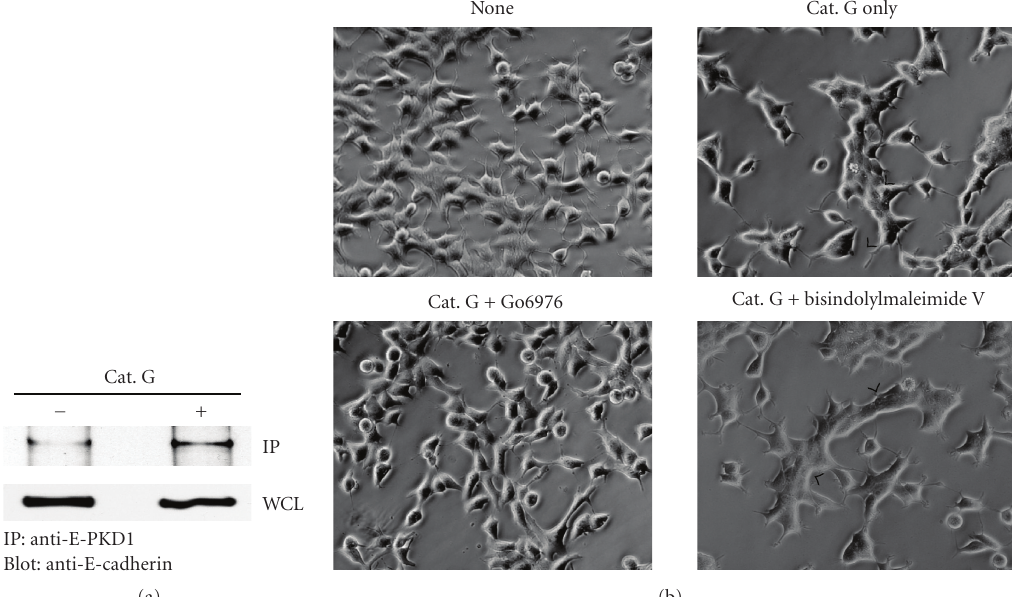
Figure 6: Cathepsin G promotes E-cadherin/PKD1 complex formation in MCF-7 cells. MCF-7 cells treated with cathepsin G for 10 hours were analyzed by immunoprecipitation and western blot analysis as described in Materials and Methods. (a) Immunocomplexes with anti- PKD1 antibody or whole-cell lysates (WCLs) were analyzed by immunoblotting using an anti-E-cadherin antibody. (b) After washing, the adherent cells were treated with cathepsin G in the absence or presence of 5 μ M Go6976 or 5 μ M of the negative control compound bisindolylmaleimide V for 5 hours. Cells were then analyzed by phase-contrast microscopy. Cathepsin G-induced cell condensation was analyzed at the original magnification: × 200. Arrowheads indicate the site of cell condensation in the cathepsin G-treated cells, while cell condensation was not observed in the cells treated with cathepsin G and